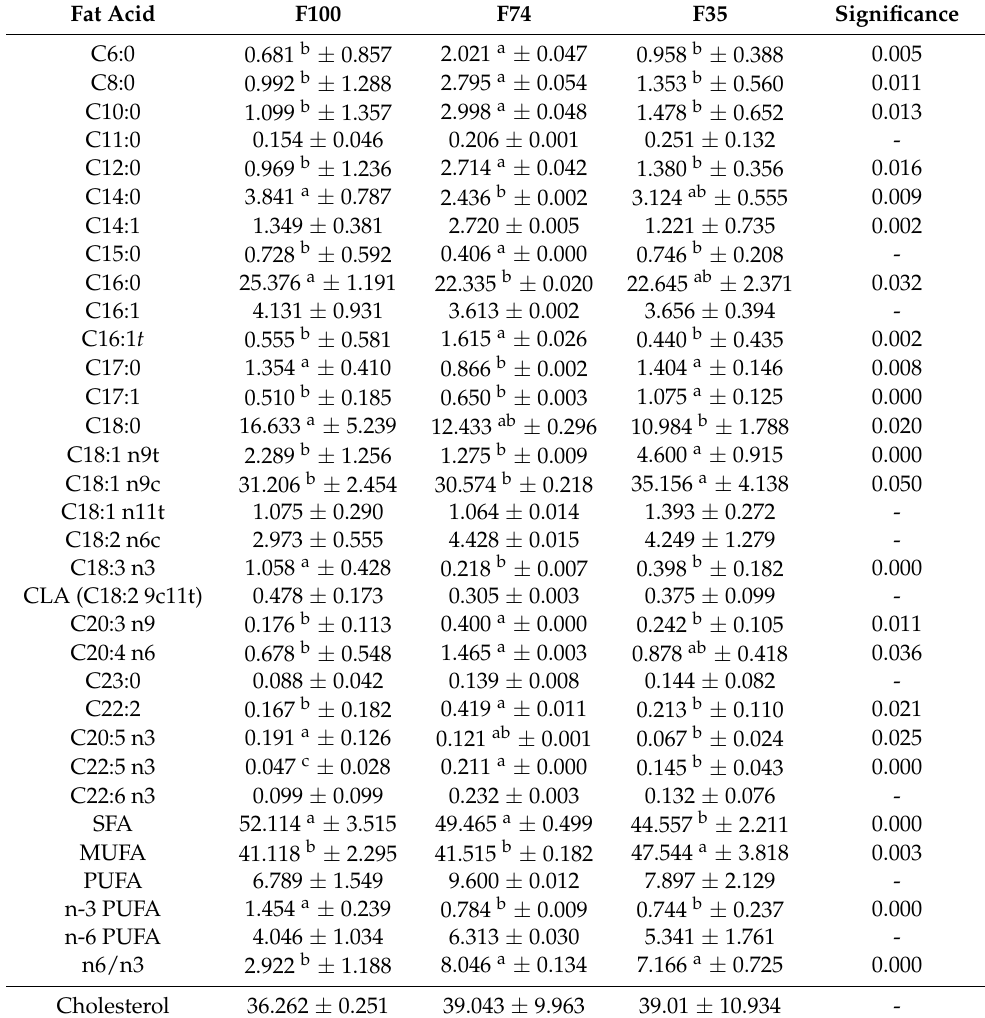
Table 3. Fatty acids (as g/100 g of fatty acids) and cholesterol of beef samples (mean ± SD). Fat